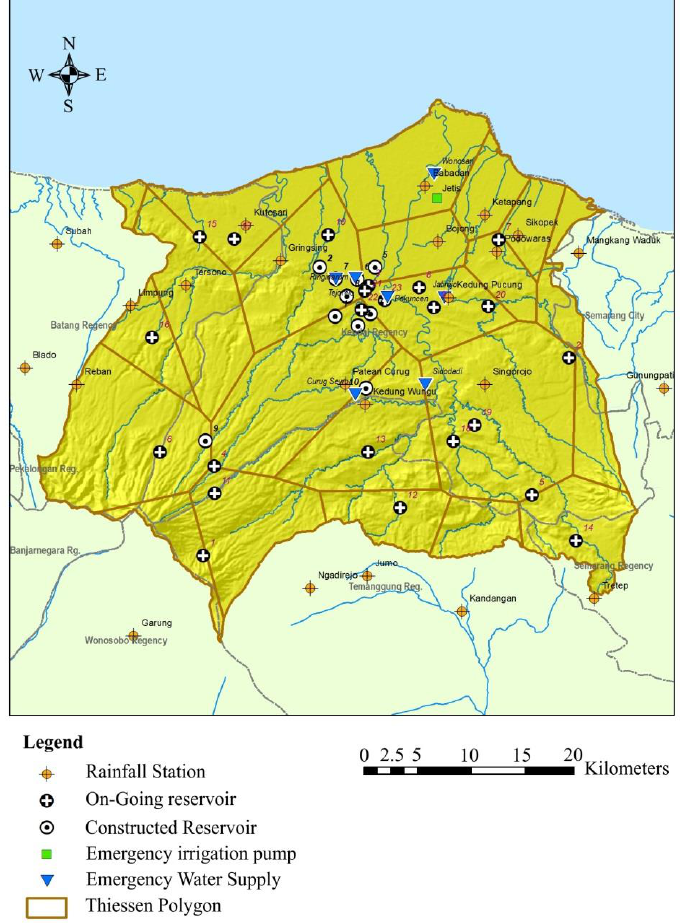
Figure 2. Locations of small reservoirs in the Bodri-Kuto river basin.